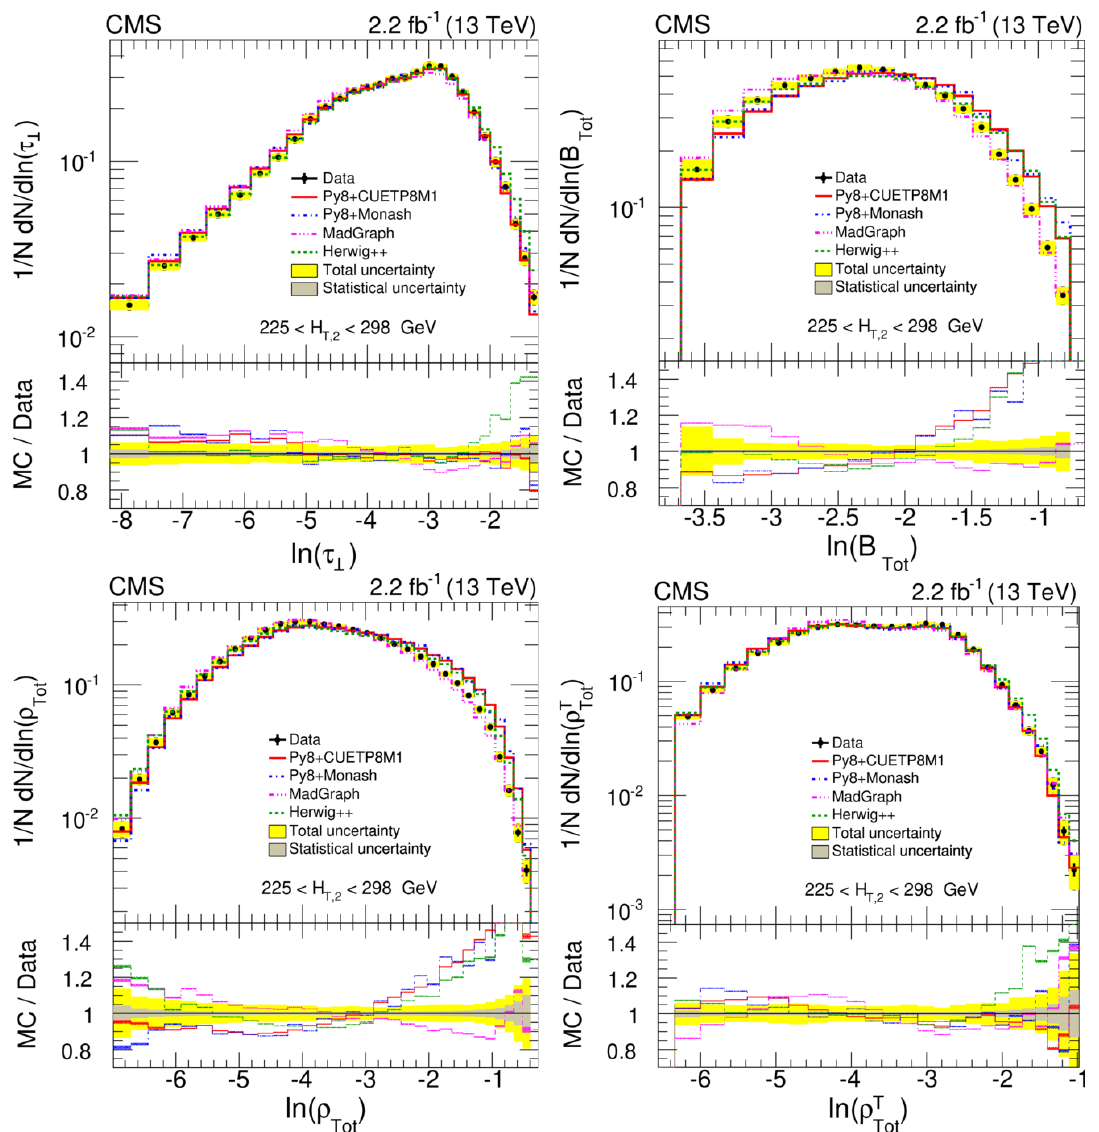
Figure 6 . Normalized di(cid:11)erential distributions of unfolded data compared with theoretical (MC) predictions of pythia 8 CUETP8M1 (red line), pythia 8 Monash (blue dash-dotted line), Mad- Graph 5 a mc@nlo (pink dash-dot-dotted line) and herwig++ (brown dash-dot-dotted line) as a function of ESV: complement of transverse thrust ( (cid:28) ? ) (upper left), total jet broadening ( B Tot ) (upper right), total jet mass ( (cid:26) Tot ) (lower left) and total transverse jet mass ( (cid:26) T 225 < H T ; 2 < 298 GeV. In each ratio plot, the inner gray band represents statistical uncertainty and the yellow band represents the total uncertainty (systematic and statistical components added in quadrature) on data and the MC predictions include only statistical uncertainty.